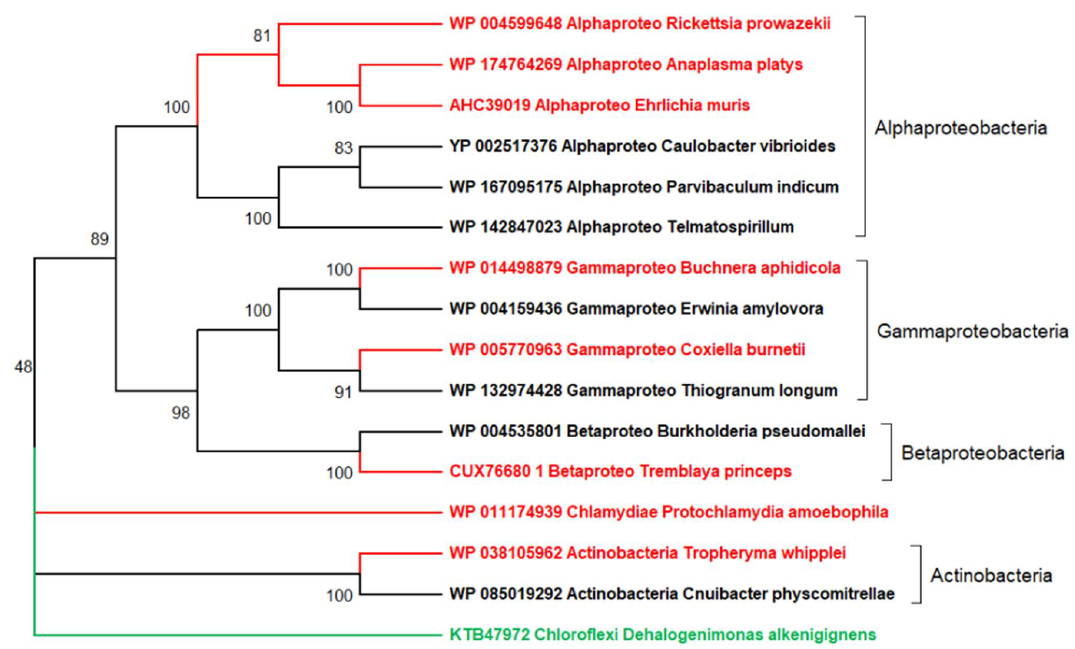
Figure 2. A more realistic representation of the origin and evolution of the obligate intracellular parasitic bacteria depicted in Figure 1. The neighbor-joining tree was generated from 974 conserved sites in the multiple alignment of 16 DNA polymerase alpha subunits using the JTT substitution matrix. The protein NCBI identifiers are indicated. The red branches correspond to the 7 obligate intracellular parasites while free-living relatives are in black. The green branch corresponds to a distant bacterium from the Chloroflexi phylum, used as outgroup. This tree suggests (with strong statistical support) that the parasitic bacteria independently originated at least 5 times from within 5 lineages also containing free living members: once from within Actinobacteria and Betaproteobacteria , twice from Gammaproteobacteria , and once early in the Alphaproteobacteria class from which three members of the order Rickettsiales emerged. In each case, the switch to a parasitic lifestyle was associated to the loss of essential genes (reductive evolution) nowadays documented by direct comparative